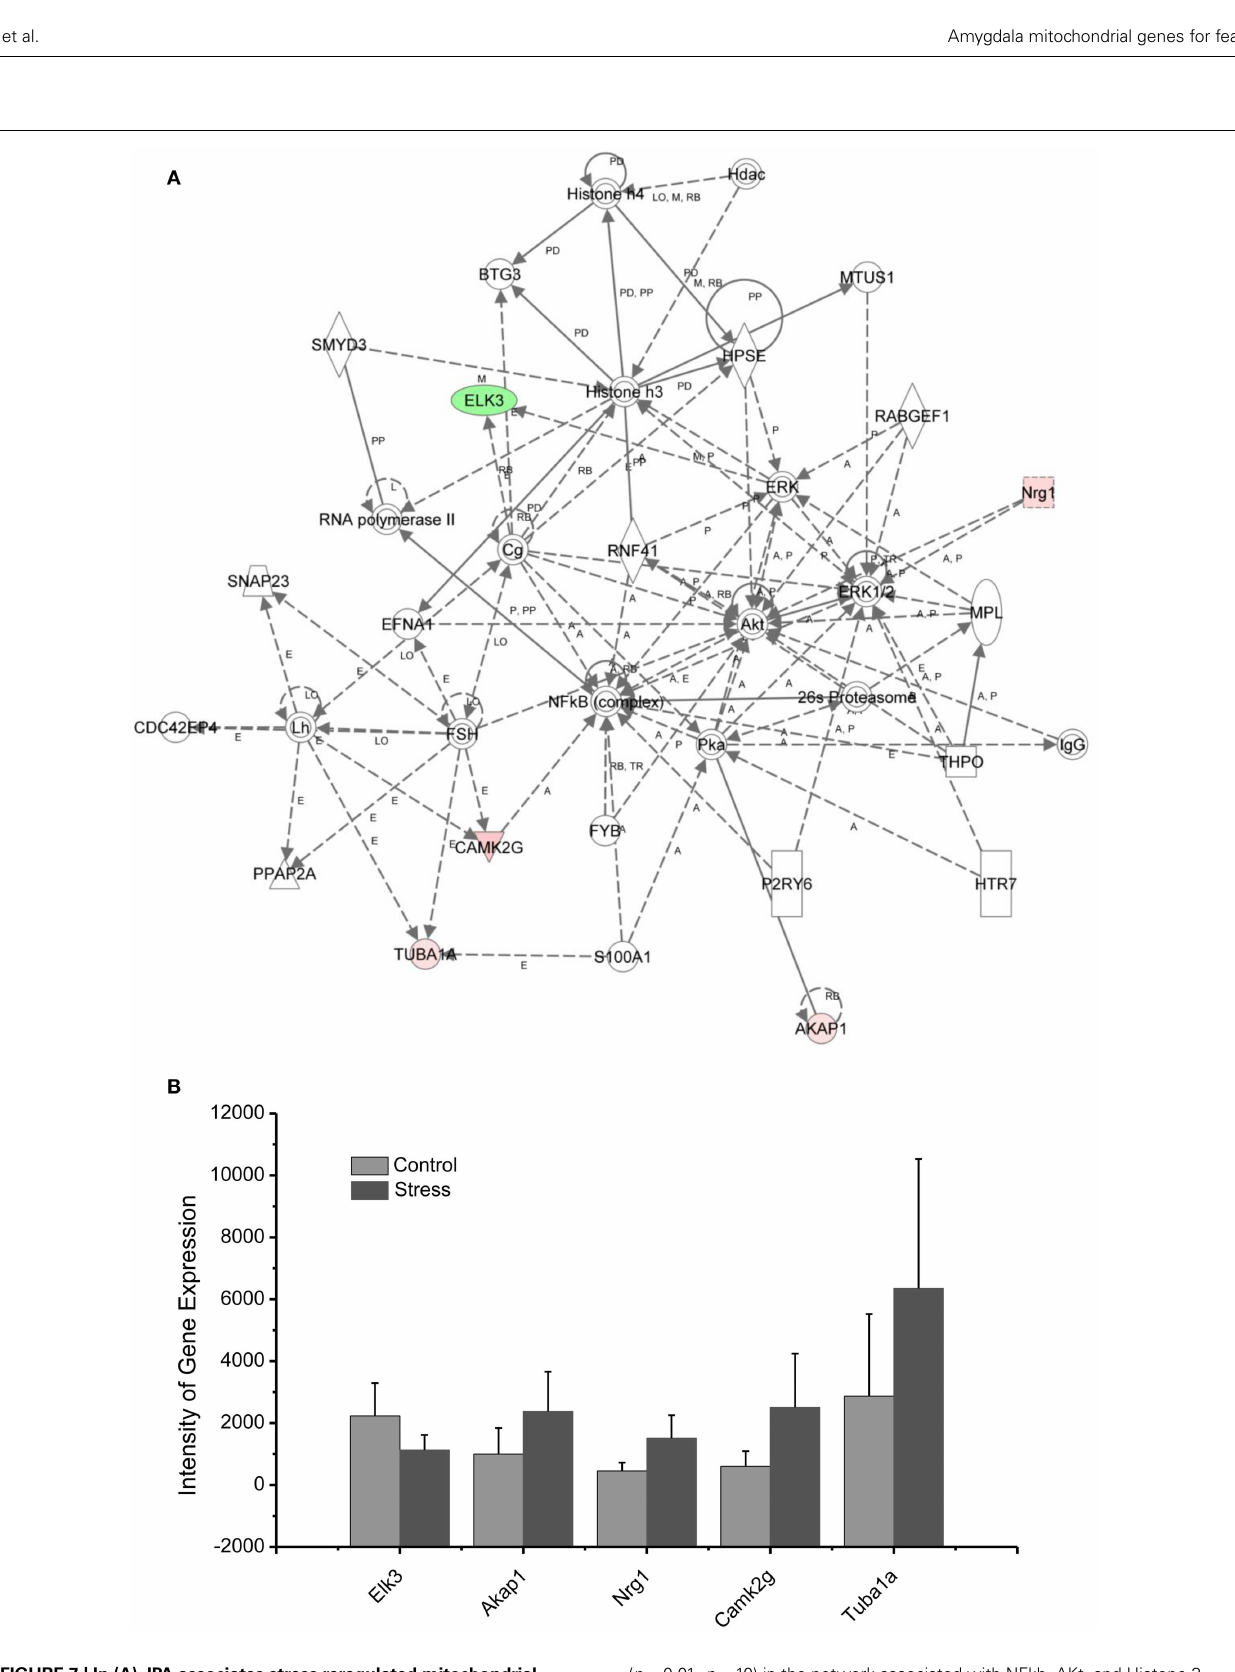
FIGURE 7 | In (A), IPA associates stress reregulated mitochondrial- related genes with the network containing NFkb,Akt, and Histone 3 . (B) is a bar graph plotted with mean ± SD of the intensity of up- or downregulated genes for the stressed ( n = 10) and controlled amygdala